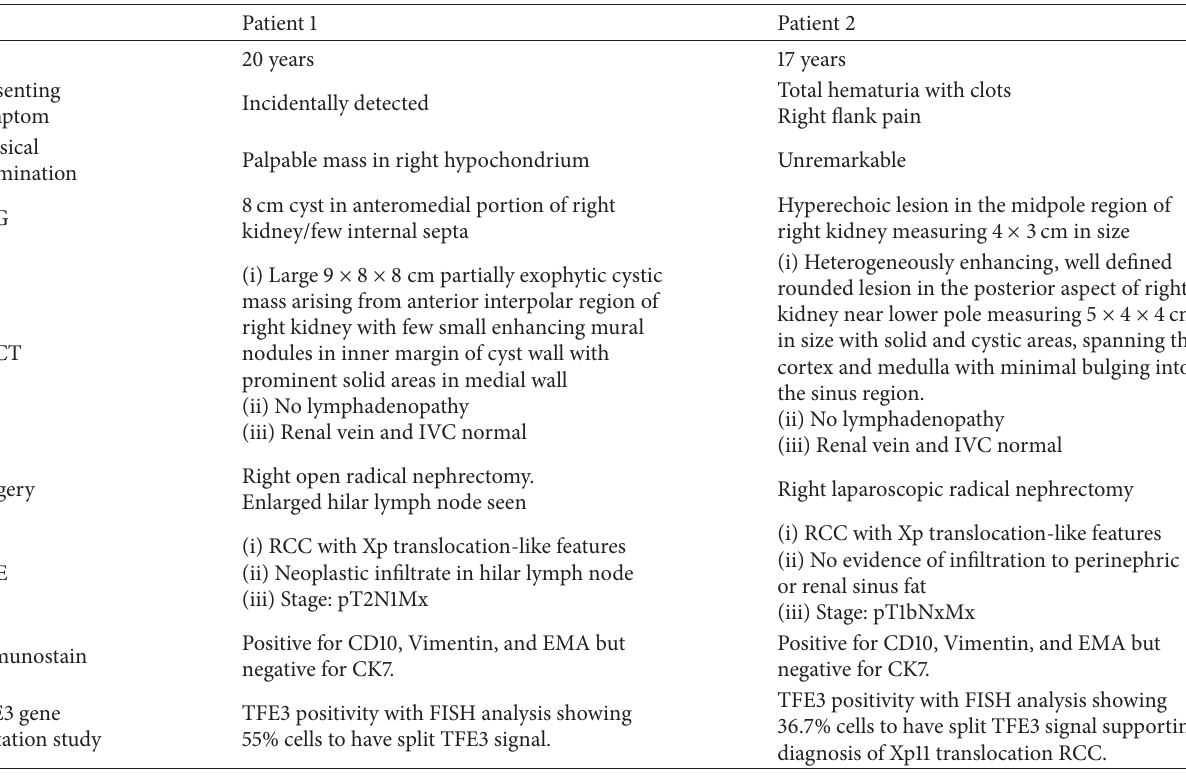
Table 1: Summarizing the findings in both patients with Xp11 translocation RCC.